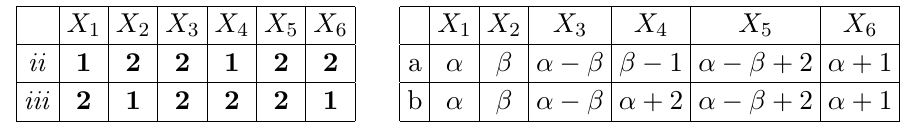
Table 22. SU ( 2 ) L (left) and U ( 1 ) Y (right) assignments for particles X 1 to X 6 of diagrams in (cid:12)gure 4.